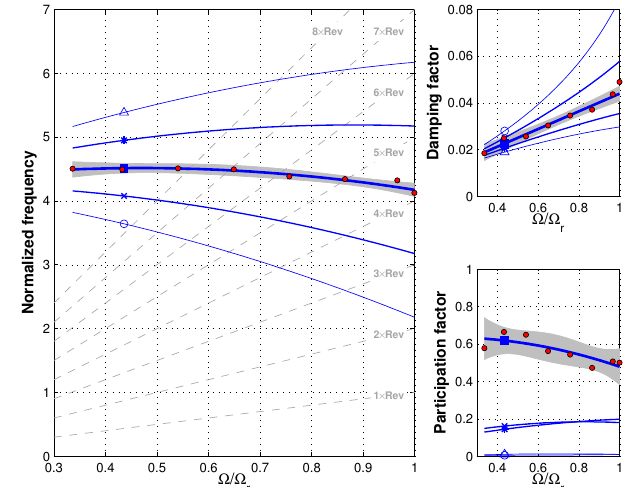
Figure 5. Periodic Campbell diagram of the first blade edgewise mode obtained from PARMAX identifications. The results of the single identifications along with the confidence level of the fitting curves are shown. Participation factors are computed in the rotating reference frame.